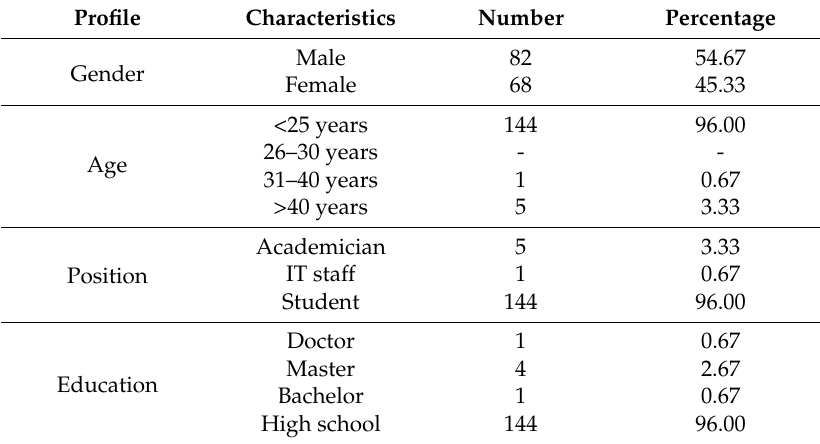
Table 3. Profiles of respondents.